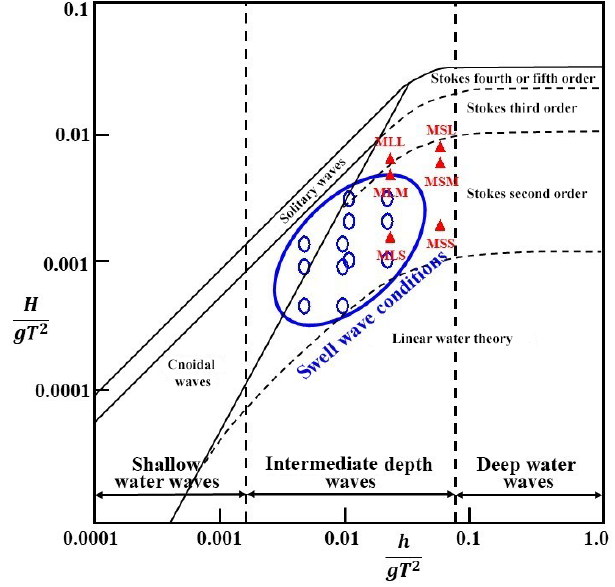
Figure 5. The present experiment and wave conditions of the real- world cases (after Le Méhauté, 1976). The solid red triangles rep- resent the incident waves tested in this study and empty blue circles represent the swell wave conditions. The x axis represents the rel- ative water depth (ratio of water depth to deep water wave length, i.e., the measure of wave dispersion). The y axis represents the wave steepness (ratio of wave height to deep water wave length, i.e., the measure of wave nonlinearity).